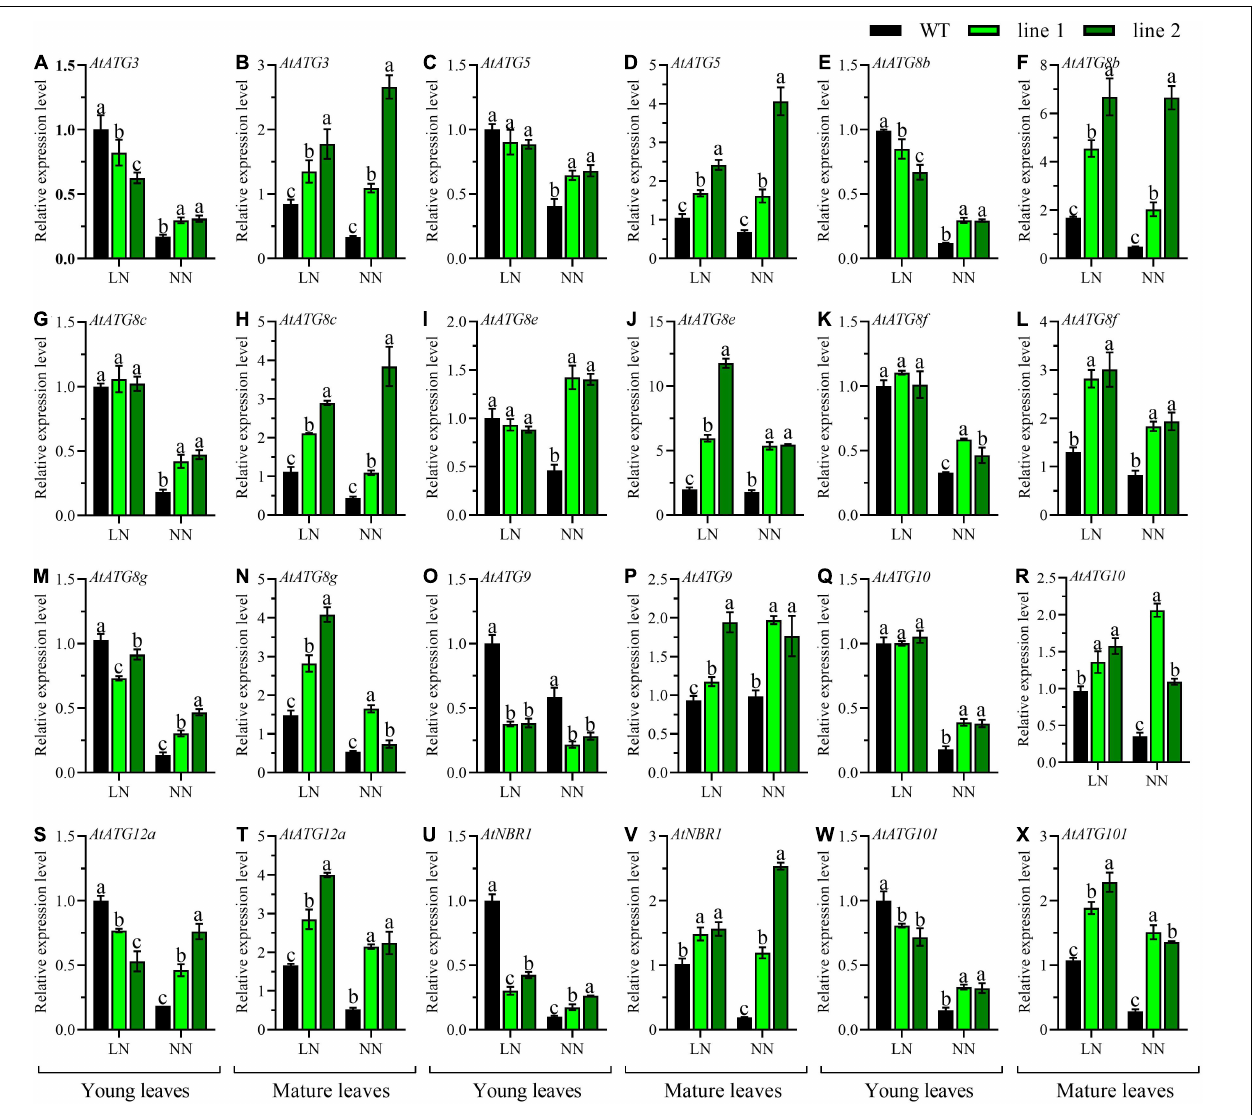
FIGURE 6 | Comparable expression analysis of genes associated with autophagy in the young leaves and mature leaves between two transgenic Arabidopsis lines and wild type. Plants were hydroponically cultured for 3 weeks under NN and then under LN and NN for 2 weeks ( n ≥ 3). ATG , autophagy related gene; NBR1 , neighbor of BRCA1. (A,C,E,G,I,K,M,O,Q,S,U,W) Genes expressed in young leaves. (B,D,F,H,J,L,N,P,R,T,V,X) Genes expressed in mature leaves. AtGAPDH was used as the internal control, and the expression level in young leaves of WT under LN was set as “1” for each gene. Three technical replicates were performed. Data are means ± SD . Significant differences are indicated by letters (ANOVA; P ≤ 0.05). WT, wild type (Col-0), line 1 and line 2, two transgenic lines. LN, low nitrogen, 0.25 mM N (0.125 mM NH 4 NO 3 ); NN, normal nitrogen, 5 mM N (2.5 mM NH 4 NO 3